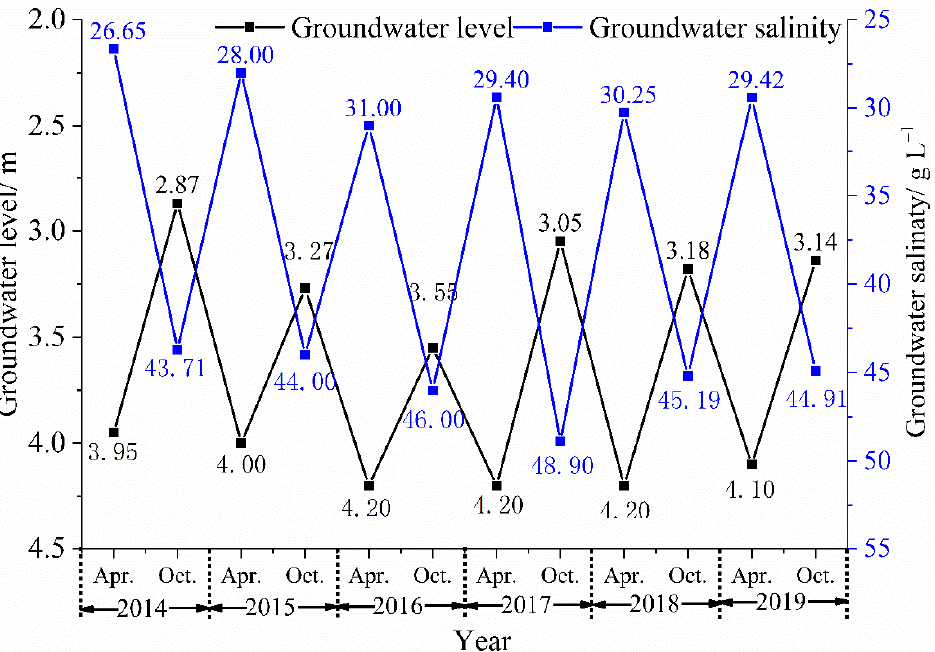
Figure 7. The dynamic changes of groundwater level and groundwater salinity in the study area from 2014 to 2019 are represented by black and blue line, respectively.